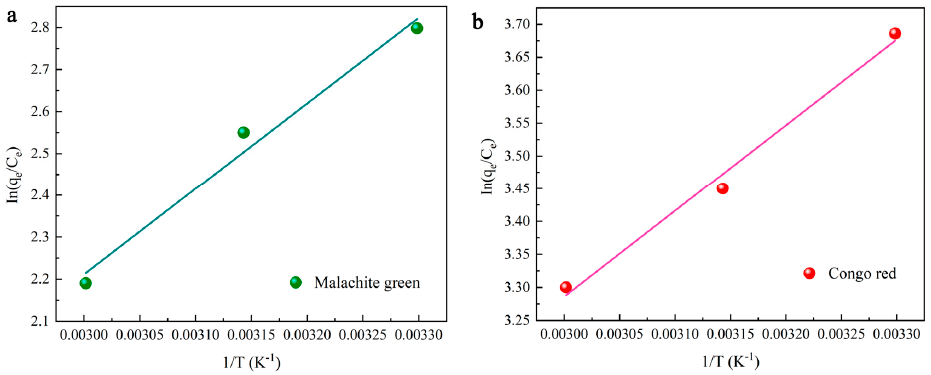
Figure 6. Thermodynamic study on the adsorption of MG ( a ) and CR ( b ) dyes by DMAL. Table 3. Thermodynamic parameters for the adsorption of two reactive dyes on DMAL. Dyes